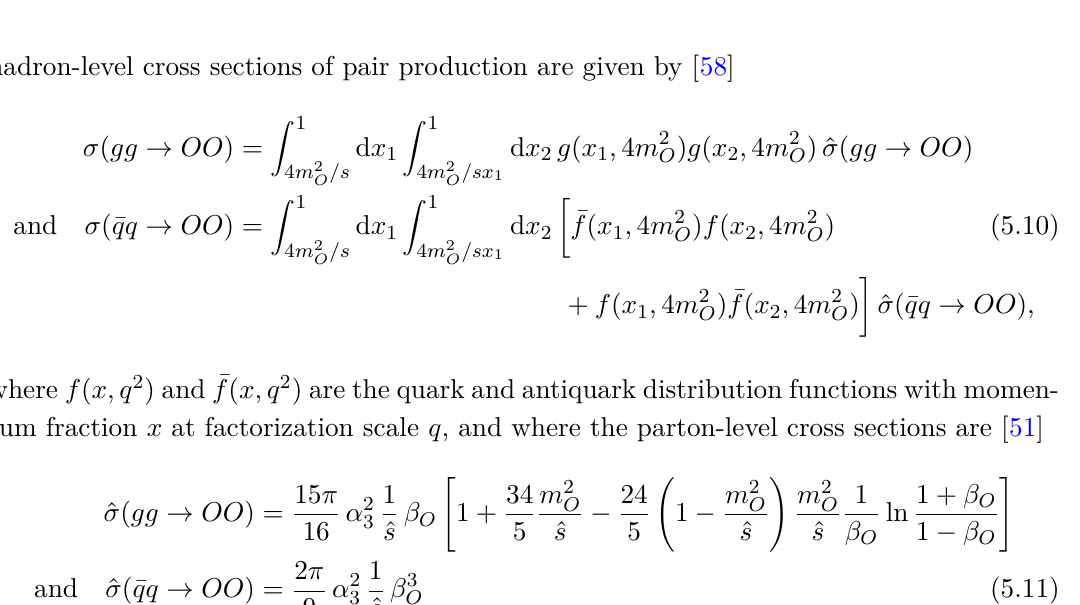
Figure 5. Diagrams for scalar sgluon pair production due to (a) gluon fusion and (b) quark- antiquark annihilation. The diagrams for pseudoscalar pair production are given by replacing O → o